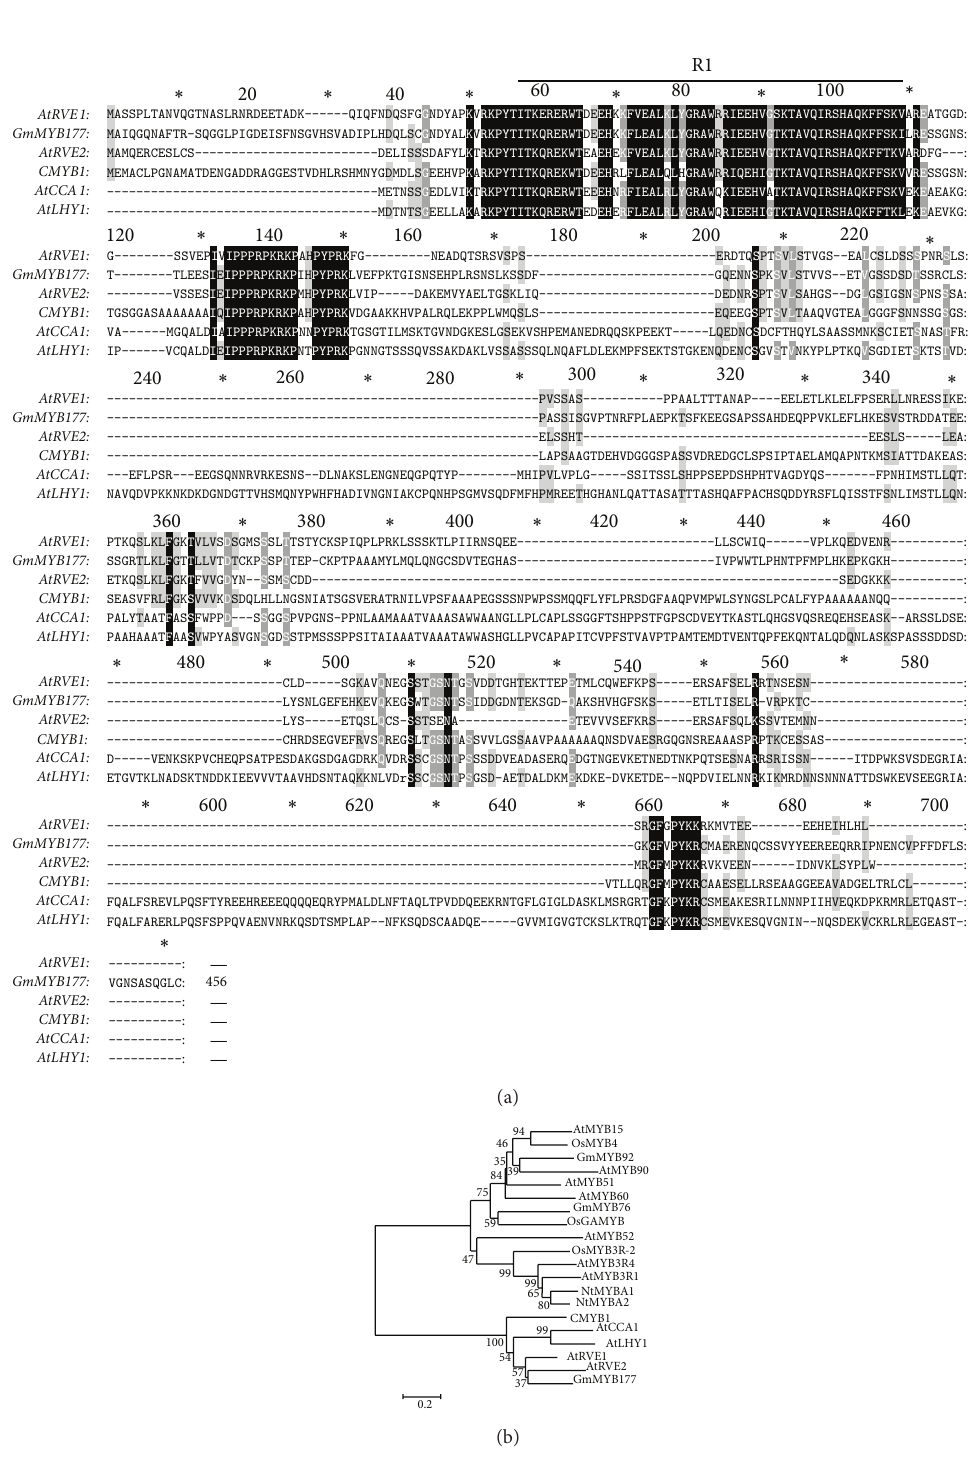
Figure 1: Multiple sequences alignment and phylogenetic tree analysis of amino acid sequences of CMYB1 with other MYB proteins. (a) Multiple sequences alignment of CMYB1 with the other R1-type MYB proteins. The upper line indicates the R1 repeat. GenBank accession numbers for the sequences: AtRVE1 (AT5G17300), AtRVE2 (AT5G37260), AtCCA1 (ATU28422), AtLHY1 (AT1G01060), and GmMYB177 (DQ822925). (b) Phylogenetic tree analysis of CMYB1 with other MYB proteins. The neighbor-joining tree was constructed with MEGA 4.0. Branchnumbersrepresentapercentageofthebootstrapvaluesin1,000samplingreplicatesandthescalebarindicatesbranchlength.GenBank accession numbers for the sequences: AtMYB15 (Y14207), OsMYB4 (D88620), GmMYB92 (DQ822903), AtMYB90 (AT1G66390), AtMYB51 (AT1G18570), AtMYB60 (AT1G08810), GmMYB76 (DQ822895), OsGAMYB (AK119607), AtMYB52 (AT1G17950), OsMYB3R-2 (BAD81765), AtMYB3R4 (AT5G11510), AtMYB3R1 (AF176005), NtMYBA1 (AB056122), and NtMYBA2